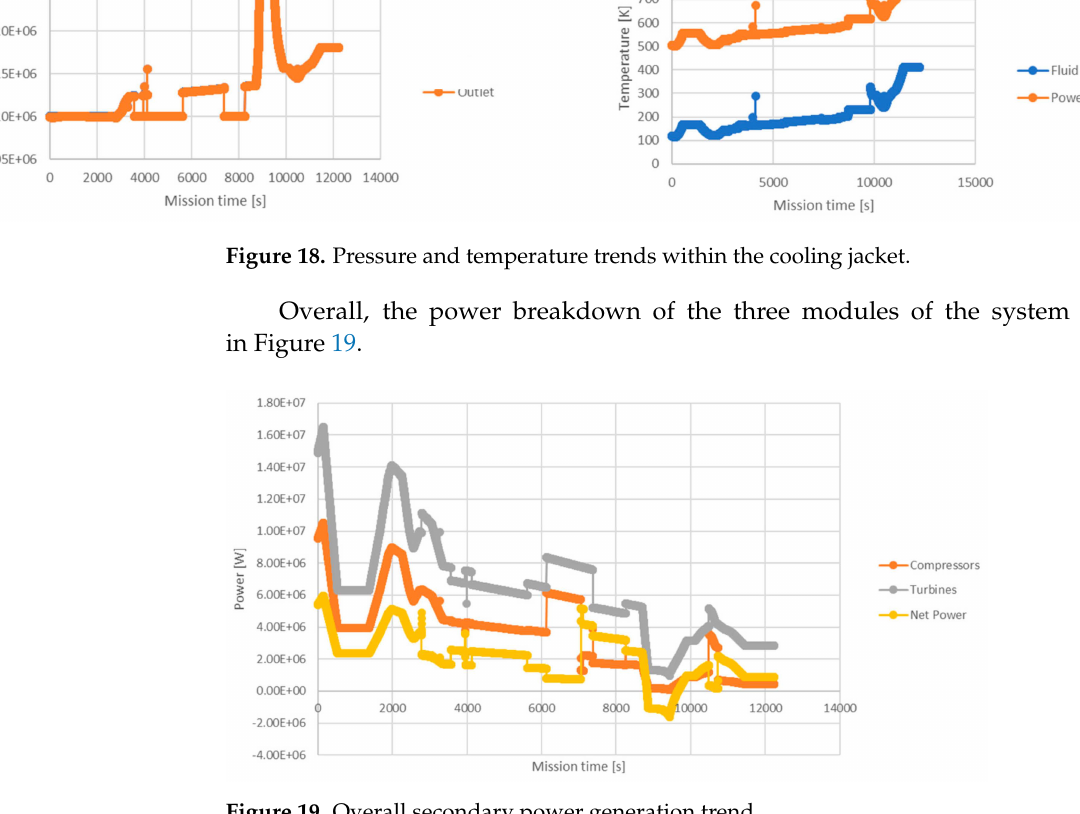
Figure 19. Overall secondary power generation